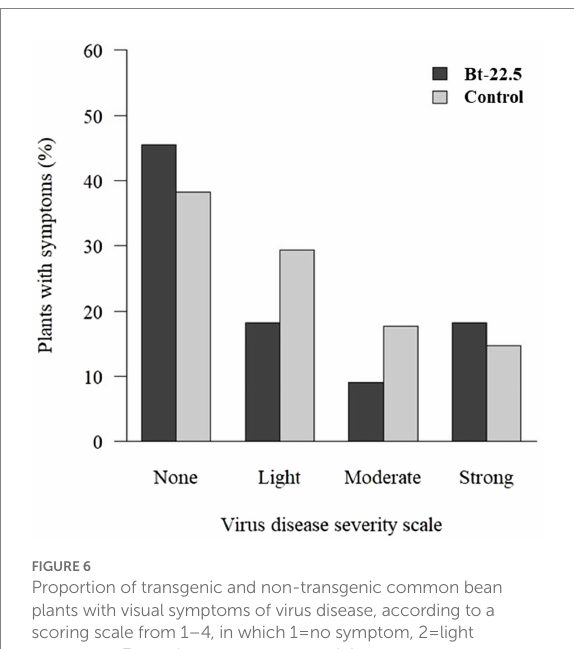
FIGURE 6 Proportion of transgenic and non-transgenic common bean plants with visual symptoms of virus disease, according to a scoring scale from 1–4, in which 1 = no symptom, 2 = light symptoms, 3 = moderate symptoms and 4 = strong symptoms (Arias et al.,